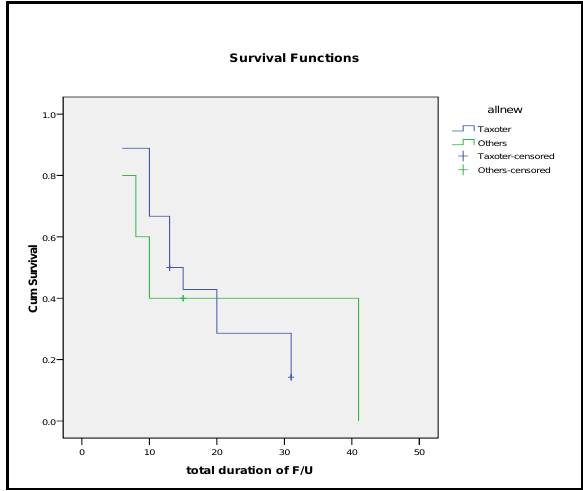
Figure 3: Kaplan Meier overall survival according to second-line chemotherapy: docetaxel vs .